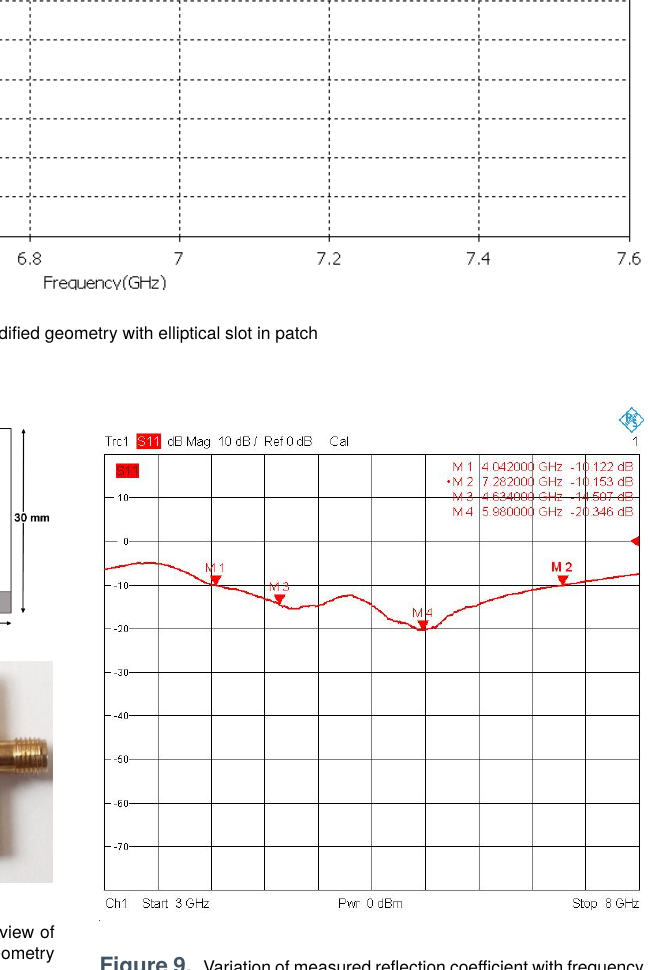
Figure 9. Variation of measured reflection coefficient with frequency for proposed